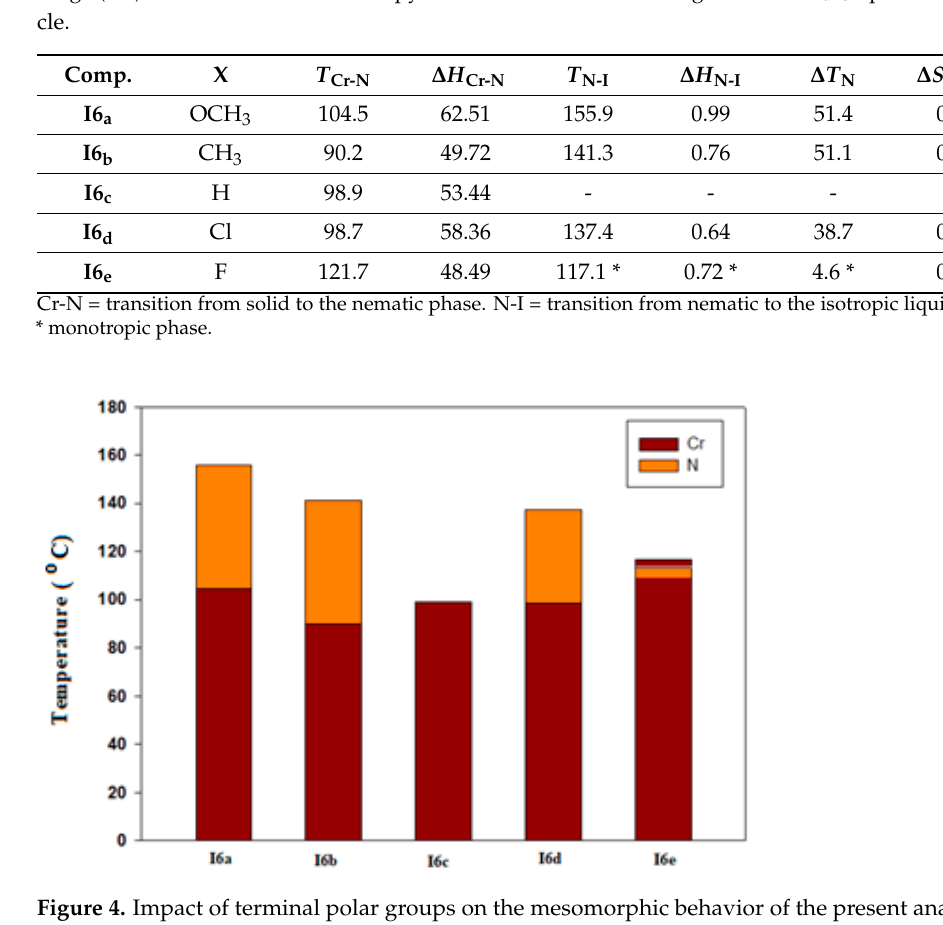
Figure 4. Impact of terminal polar groups on the mesomorphic behavior of the present analogous series, I6 a–e